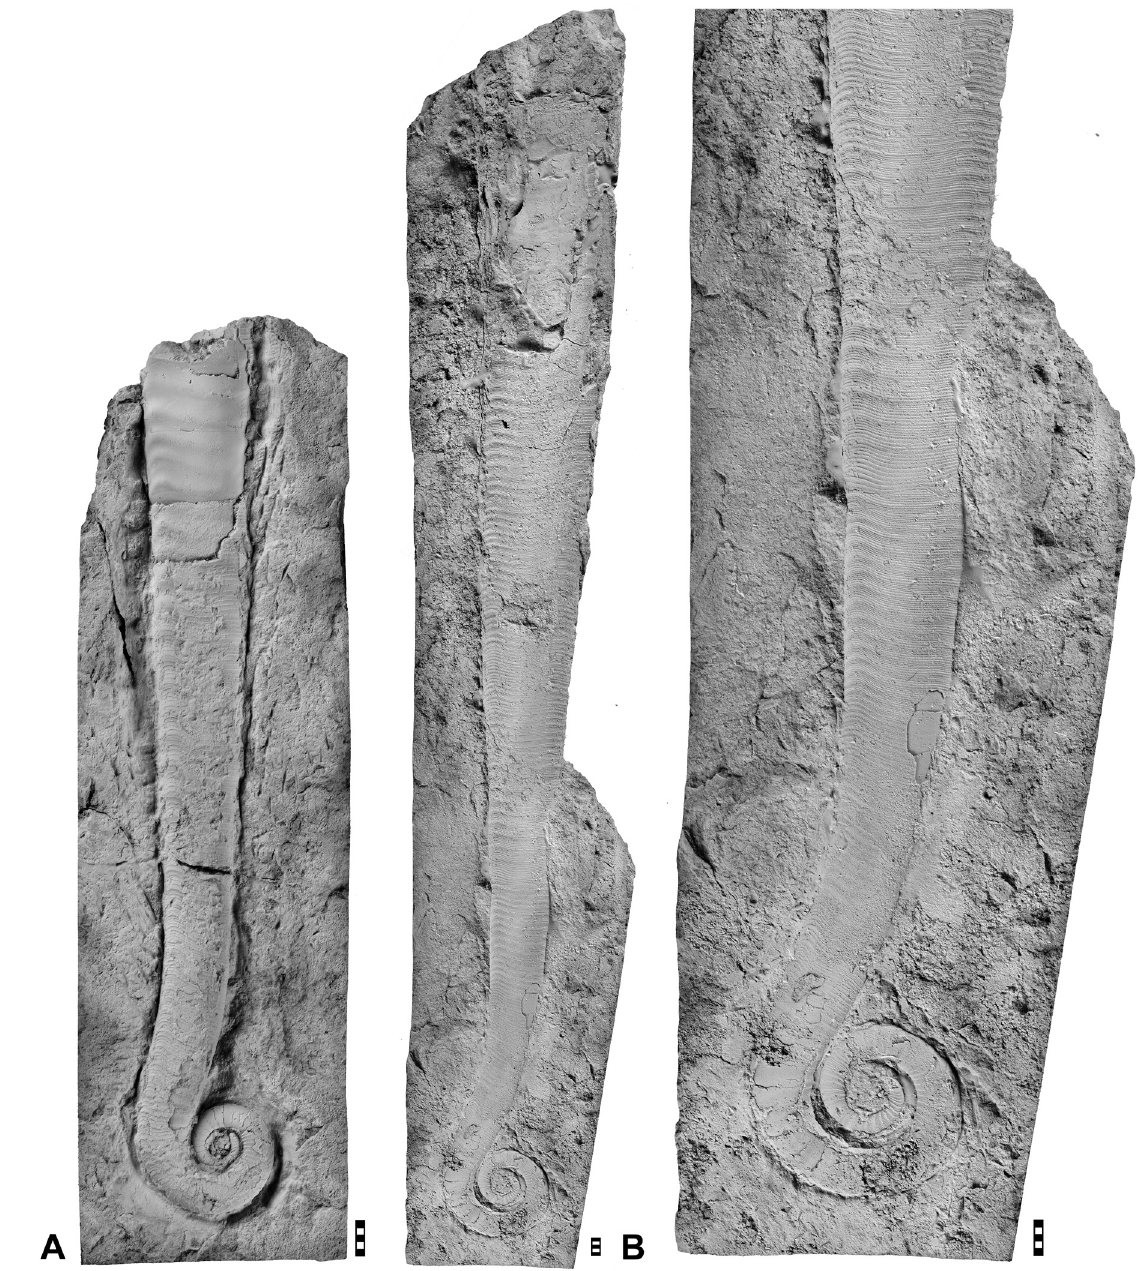
Fig. 54. Species of Lituites from the Middle Ordovician of Gärdslösa (Island of Öland, Sweden). A . Lituites baculus sp. nov., holotype MB.C.29654 (Bottke Coll.). B . Lituites bottkei sp. nov., holotype MB.C.29651 (Bottke Coll.). Scale bar units = 1